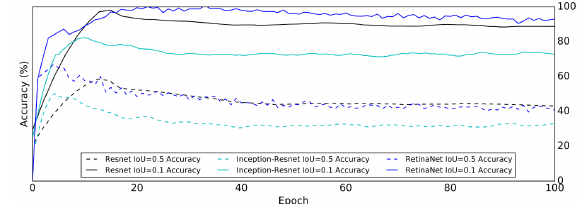
Figure 5: IoU comparison where IoU=0.5 and 0.1 thresholds are set for evaluation of the model performance. Results are approximately ~2.25x greater when IoU=0.1.